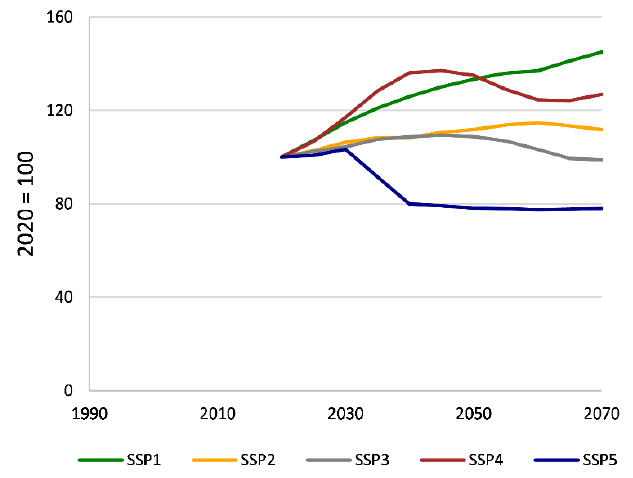
Figure 8. Global average price of fuelwood across SSPs, 2020 to 2070 projections from FOROM.